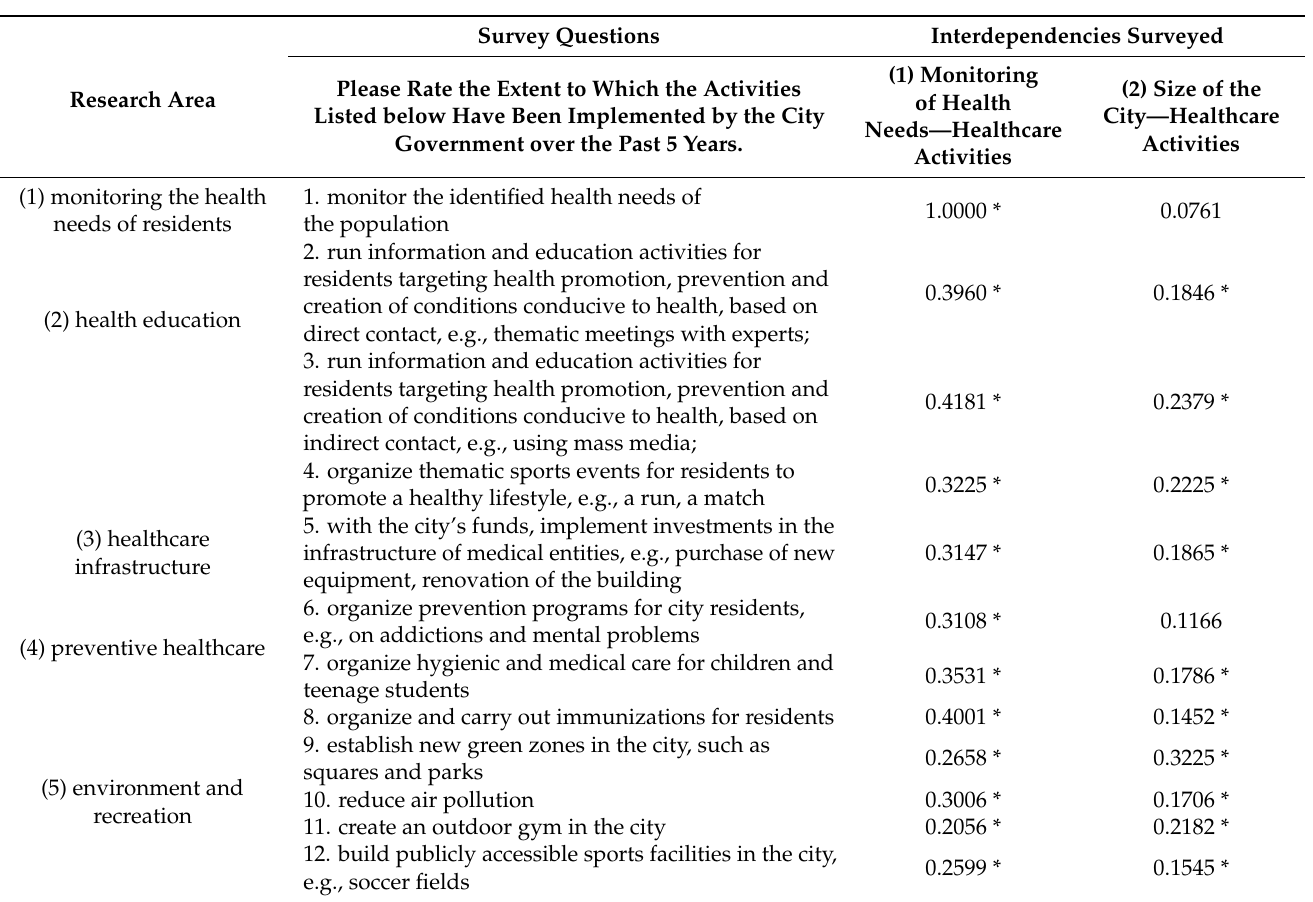
Table 3. Spearman’s rank correlation coefficients for the correlations: health needs monitoring— healthcare activities and city size—healthcare